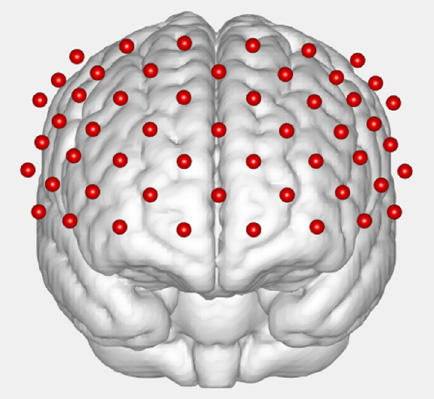
Figure 2. A schematic diagram of the distribution of the fNIRS photopoles and